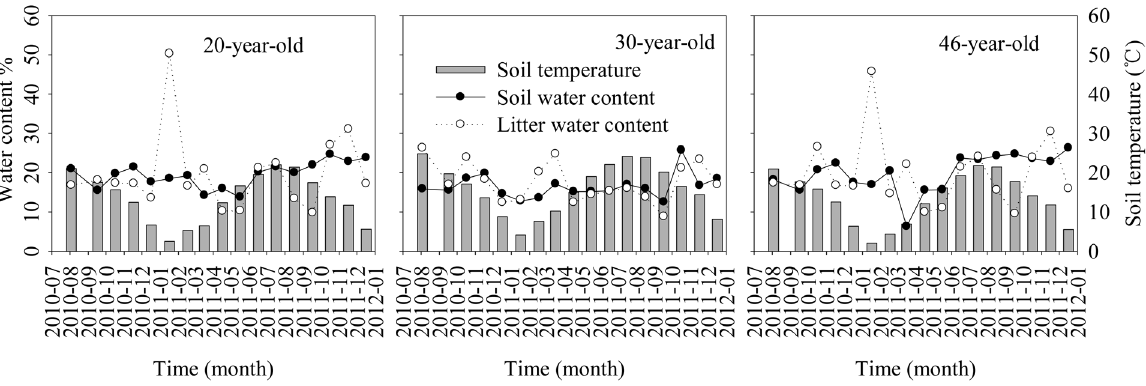
Figure 4. Soil temperature (5 cm soil depth), soil water content (5 cm soil depth) and litter water content in different-aged Pinus massoniana forests studied across the experiment period.